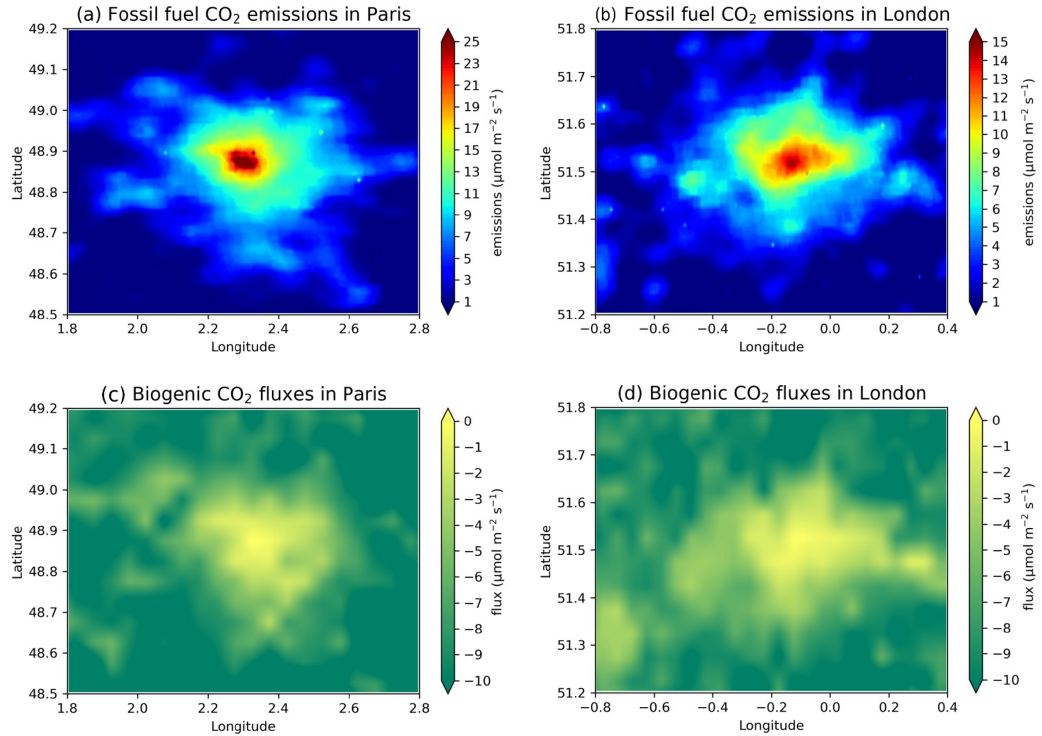
Figure 3. Monthly mean fossil fuel CO 2 emissions in April 2018 from ODIAC in Paris (a) and London (b) . Biogenic CO 2 fluxes at 12:00UTC on 15 April 2018 simulated by the SMUrF model in Paris (c) and London (d)